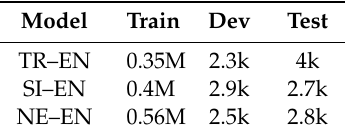
Table 2. The statistics of the three low-resource corpora.